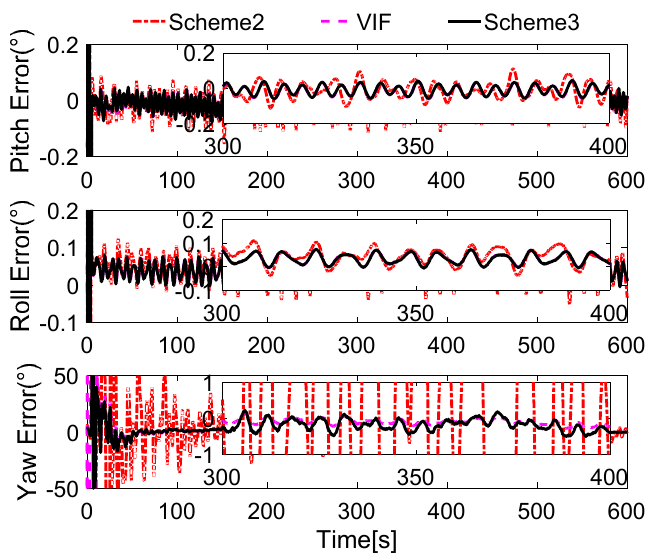
Figure 14. Curves of the reconstructed observation vectors. Sensors 2017 , 17 , 709